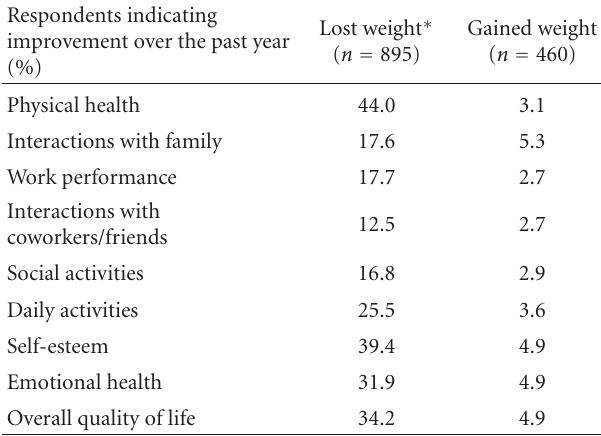
Table 3: Proportion of respondents with type 2 diabetes who self- reported (SHIELD-WQ-9) improvement in quality of life over the past year related to their weight